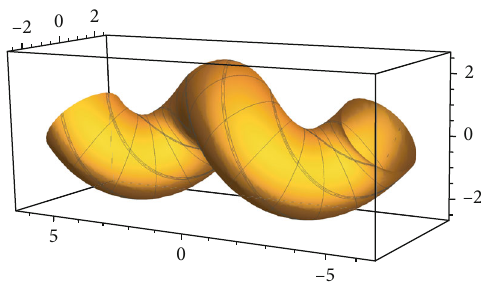
Figure 1: Tubular surface Ω